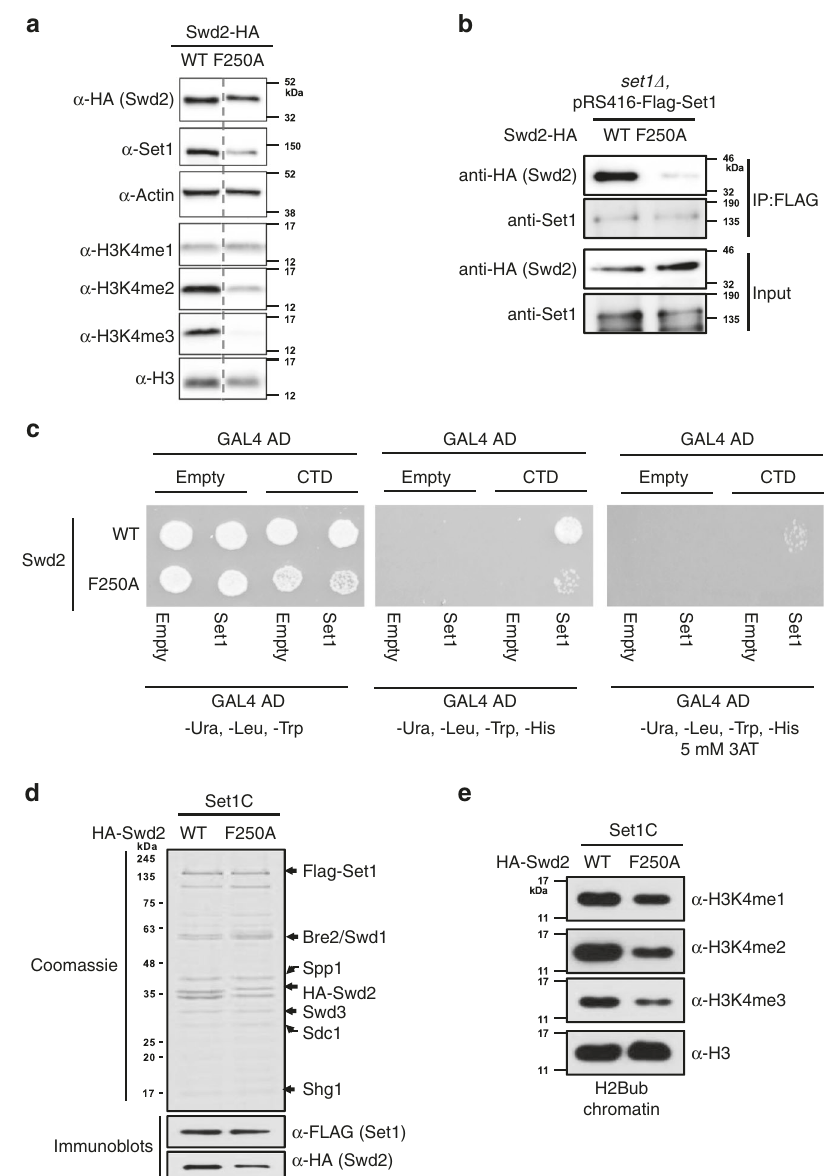
Fig. 5 The Swd2 WD40 domain is critical for COMPASS function. a Swd2 – HA or Swd2 – F250A – HA were expressed in an swd2 Δ deletion strain. Protein levels were analyzed by immunoblotting using the indicated antibodies. Actin and Histone H3 were used as loading controls. Note that samples were run on the same blot, but intervening lanes were removed (dashed line, full blots appear in Source data). b Plasmid-encoded Swd2 – HA and Swd2 – F250A – HA were expressed in FLAG-Set1 containing cells that also express the endogenous untagged SWD2 gene in the chromosome. Proteins were immunoprecipitated with anti-FLAG beads (IP:FLAG) and then immunoblotted for Set1 and Swd2-HA. c The Y2H interaction between the Gal4BD – Set1 and Gal4AD – CTD fusions was tested in strain PJ69-4A expressing wild-type (WT) or mutant (F250A) Swd2. The empty Gal4 vectors served as negative controls. Activation of the Gal4-activated HIS3 reporter was tested on plates lacking histidine, with the addition of 5 mM 3AT in the last panel for additional stringency. d Analysis of recombinant baculovirus-expressed Set1/COMPASS made with WT Swd2 or the Swd2 – F250A mutant. SDS-PAGE/Coomassie blue staining shows total protein, while immunoblotting with anti-FLAG and anti-HA show Set1 and Swd2 levels, respectively. e H2Bub chromatin was subjected to in vitro histone methyltransferase assays 16 with Swd2 WT and Swd2-F250A mutant-containing complexes shown in panel ( d ). H3K4 methylation status was monitored by immunoblotting with indicated antibodies. Histone H3 was used as an internal loading control. Source data are provided as a Source data fi